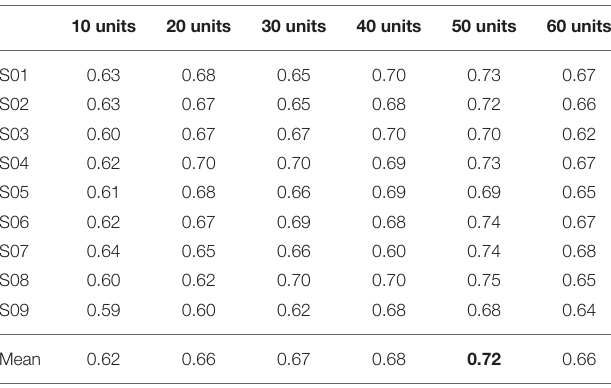
TABLE 3 | Comparison of classification accuracies based on different numbers of units in the second hidden layer for the nine subjects. 10 units